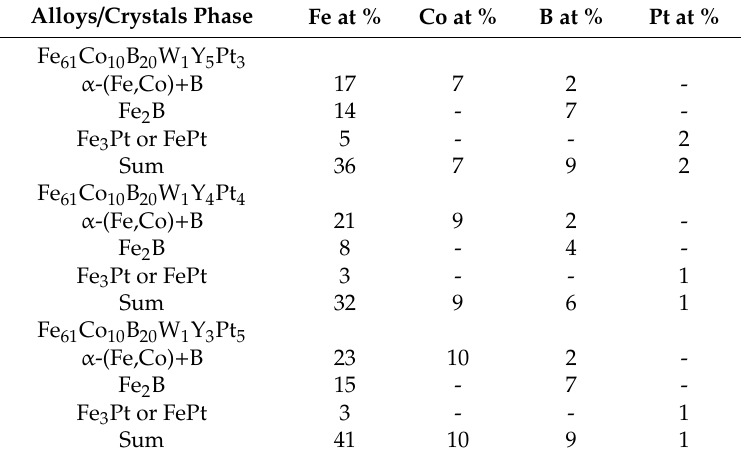
Table 2. Calculations of the percentage of atoms in the crystalline phases, in relation to the amorphous matrix (per 100 atoms in the alloy), made on the basis of Mössbauer spectra analysis.